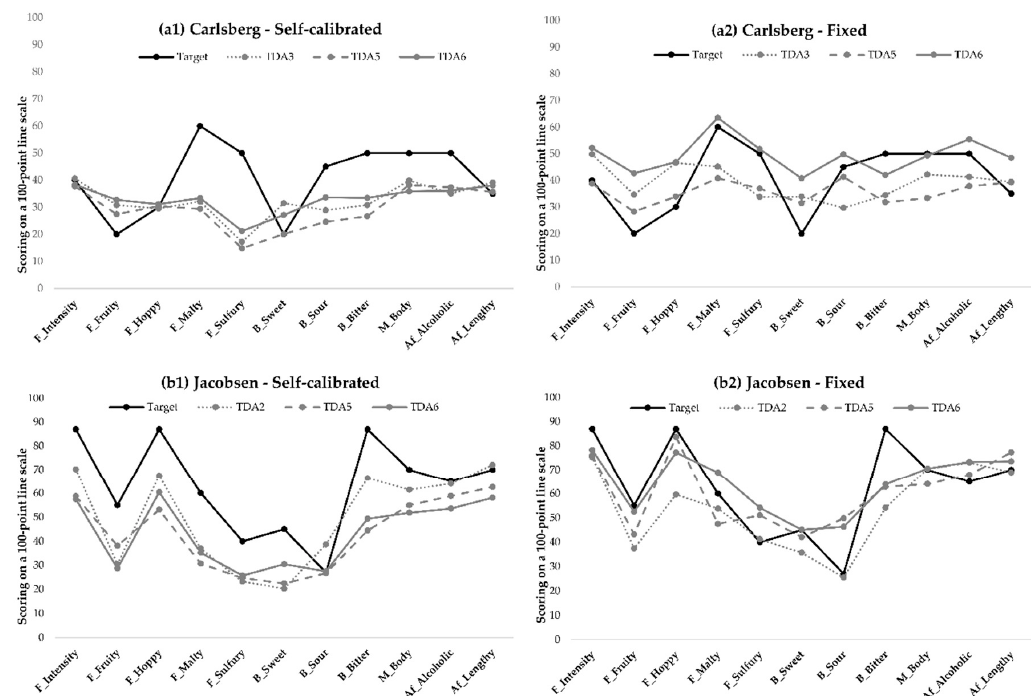
Figure 5. Performance progression (mean scores) compared to the target value over training sessions TDA 2–6 for two products, ( a ) Carlsberg and ( b ) Jacobsen, and both panels, ( b1 ) self-calibrated and ( b2 ) fixed. Data are averaged over panelist and replicate.